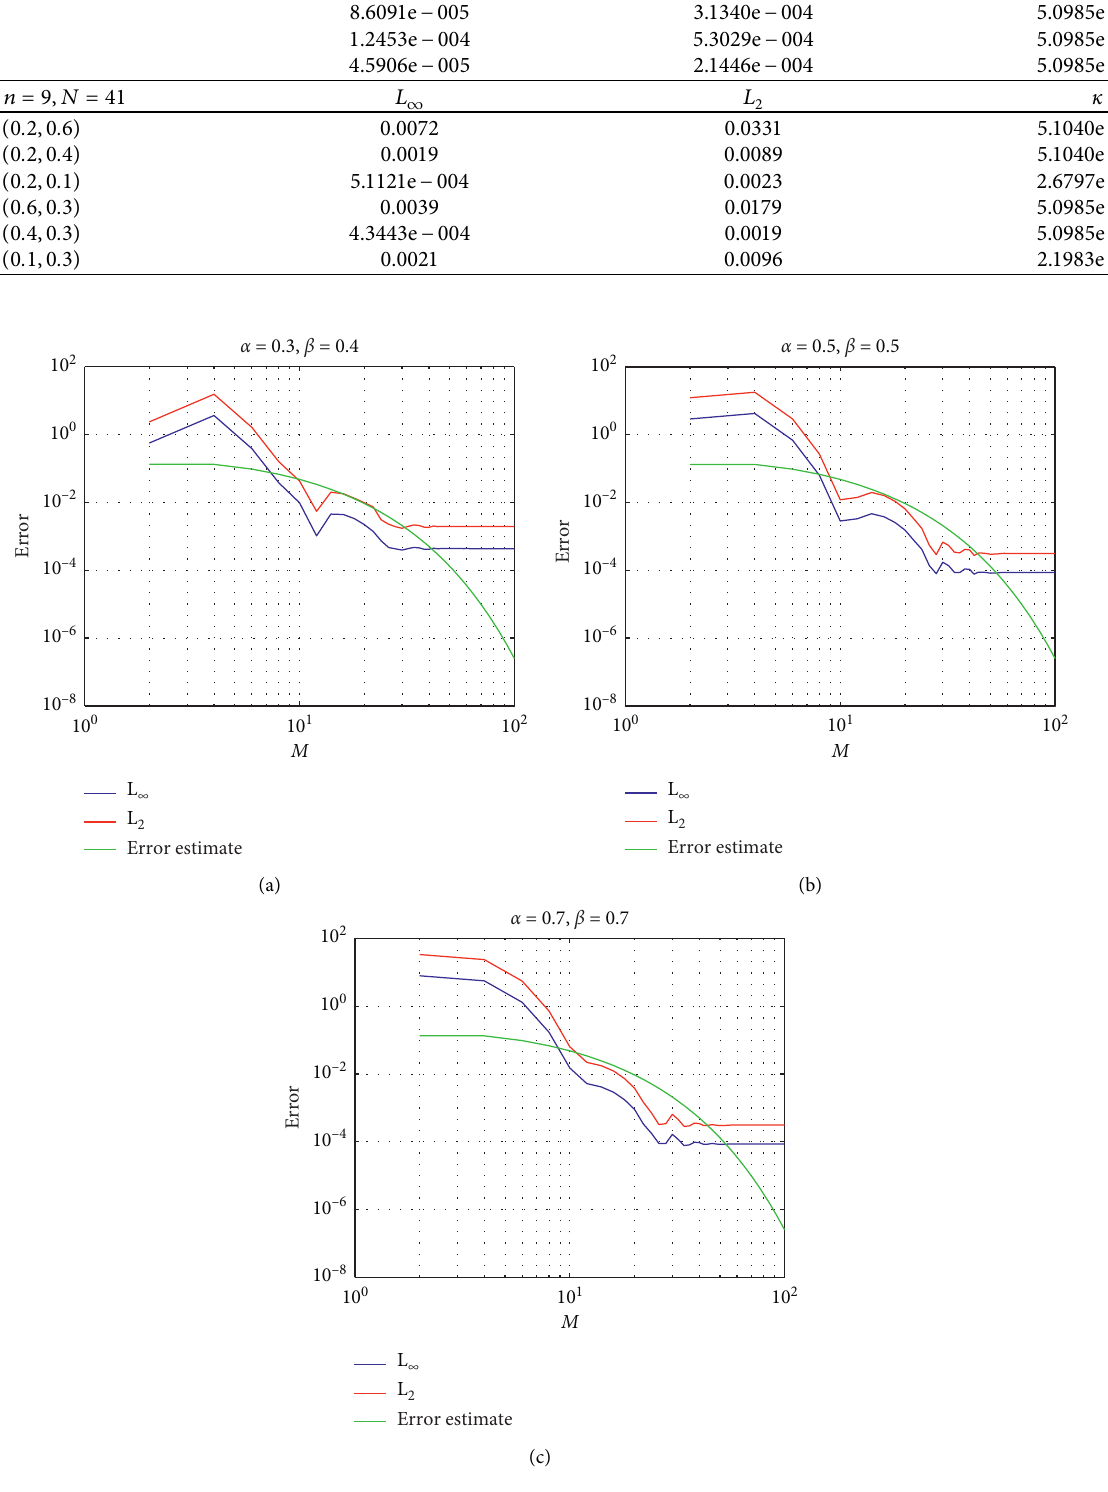
Figure 2: Error versus quadrature points M at N � 41, n � 9, and t � 1 and various values of α , β corresponding to Problem